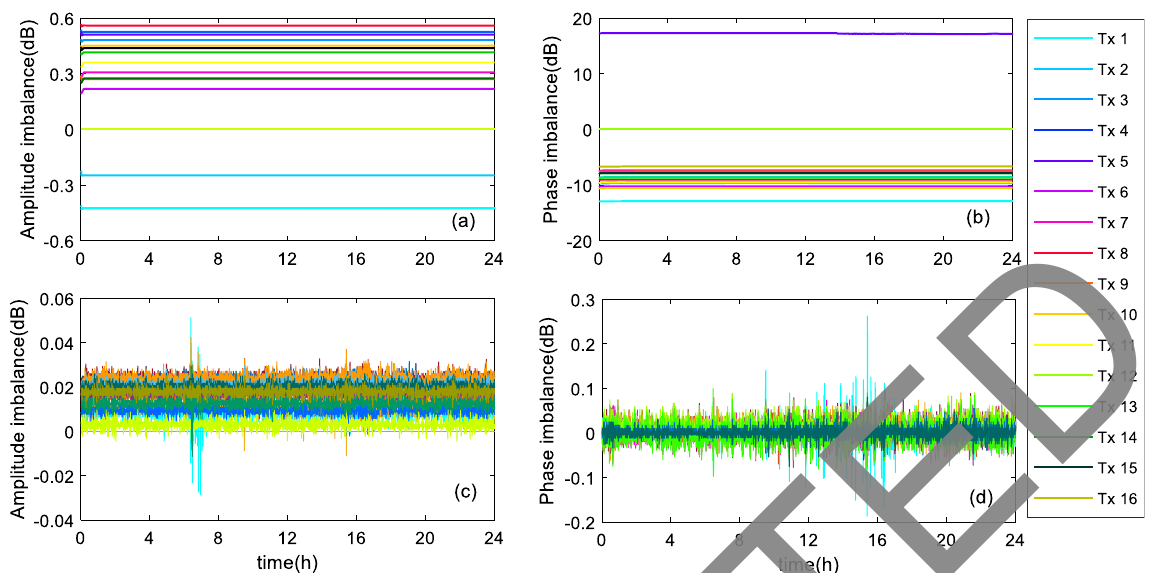
Figure 5. Imbalances between transmitters before (top) and after (bottom) calibration. The data are measured continuously in 24 h. (a) The amplitude imbalance before correction. (b) The phase imbalance before correction. (c) The amplitude imbalance after correction. (d) The phase imbalance after correction.